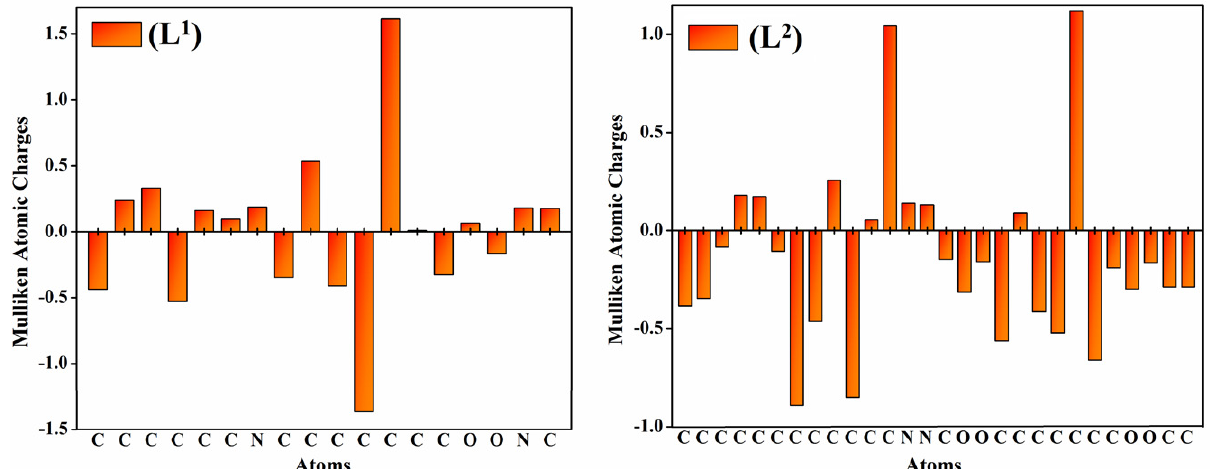
Figure 6. Histogram for Mulliken atomic charges of ligands (L 1 ) & (L 2